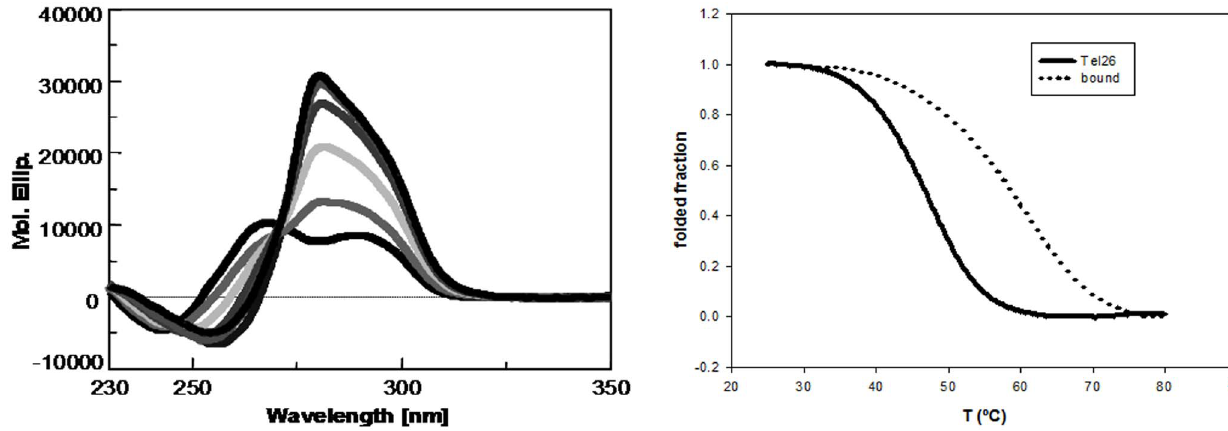
Figure 6. (K34) 2 Ni(II) promotes G-quadruplex folding of the tested telomeric sequences. Dichroic spectra of 4 m M Tel 26 in the presence of increasing concentrations of (K34) 2 Ni(II) at 45 u C (Panel A) and thermal denaturation profiles of the same oligonucleotide (Panel B) recorded at 290 nm in the absence (solid line) or in the presence of (K34) 2 Ni(II) at 2:1 molar ratio (dotted line) in 10 mM Tris, 20 mM KCl at pH 7.5.